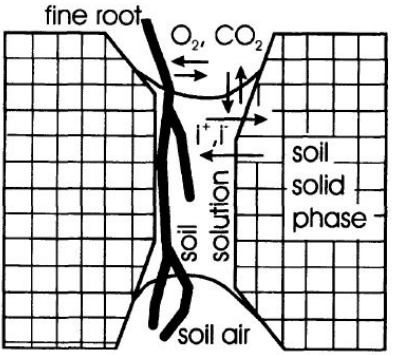
Figure 4. Basic regulation unit of soils in the range of a few mm 3 controlling the dissolution of minerals and organic matter, the transport of diluted compounds (i + and i − ) and simultaneously enabling the oxygen supply and carbon dioxide discharge. Thus, within these small, well-structured soil volumes, all essential demands for root growth are given under normal conditions: supply with water and nutrients, as well as sufficient aeration (from Reference [9]).